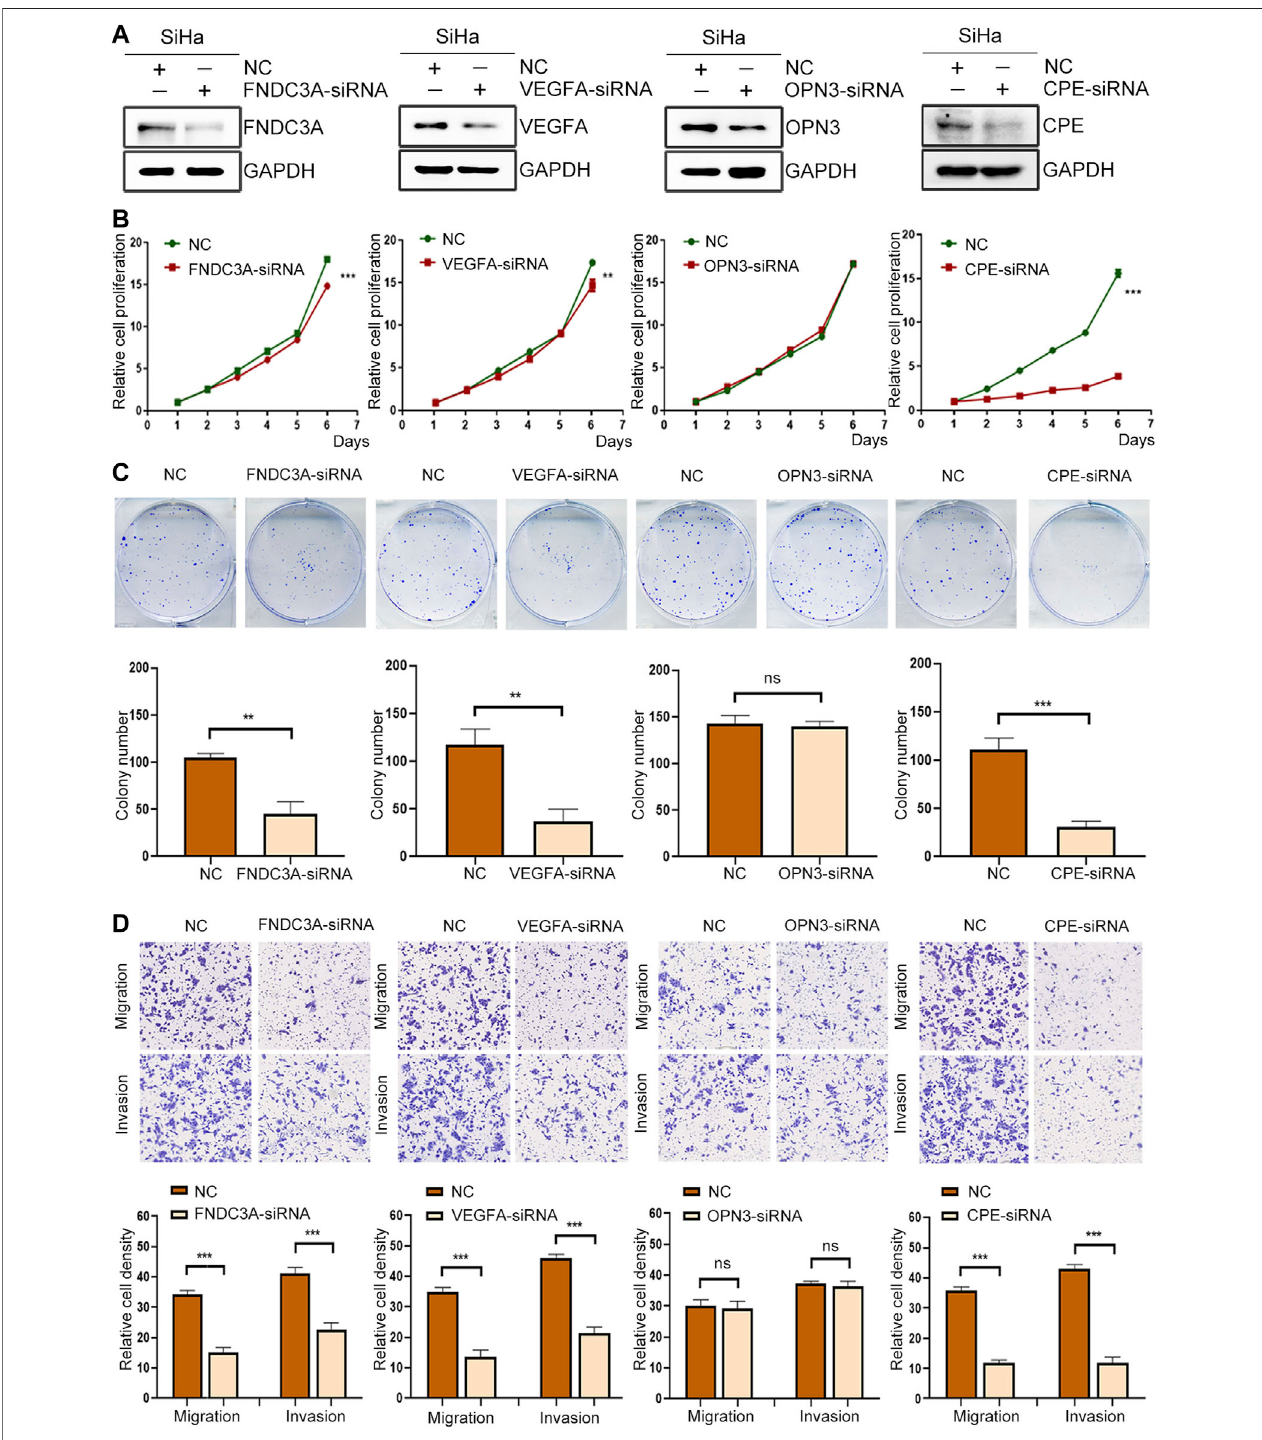
FIGURE11| FNDC3A, VEGFAorCPEpromotedtheproliferation,invasionandmigrationofSiHacells. (A) WesternblottinganalysisofFNDC3A,VEGFA,OPN3or CPE expression in SiHa cells transfected with their siRNA. (B) Cell proliferation abilities were detected by CCK-8. (C) Colony number were detected. (D) Cell migration and invasion abilities were evaluated by Transwell assay. NC: Negative Control. **, p < 0.01; ***, p < 0.001.